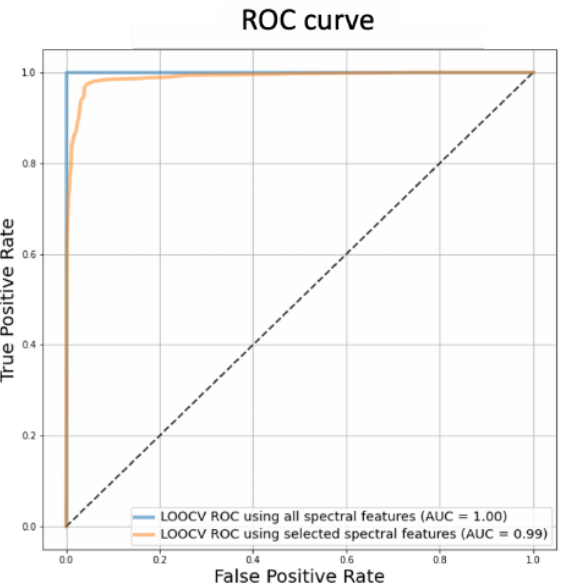
Figure 8. ROC-AUC curves for MSI-based LR models before (blue line) and after feature selection (orange